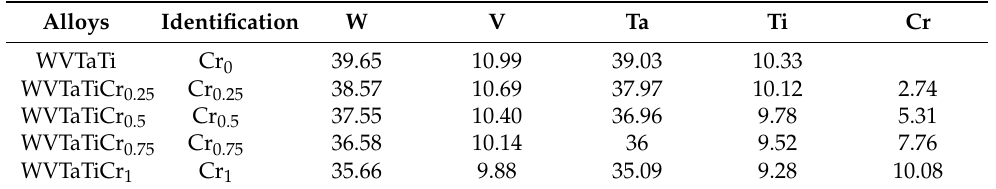
Table 2. The mass fraction of each element of alloy coatings